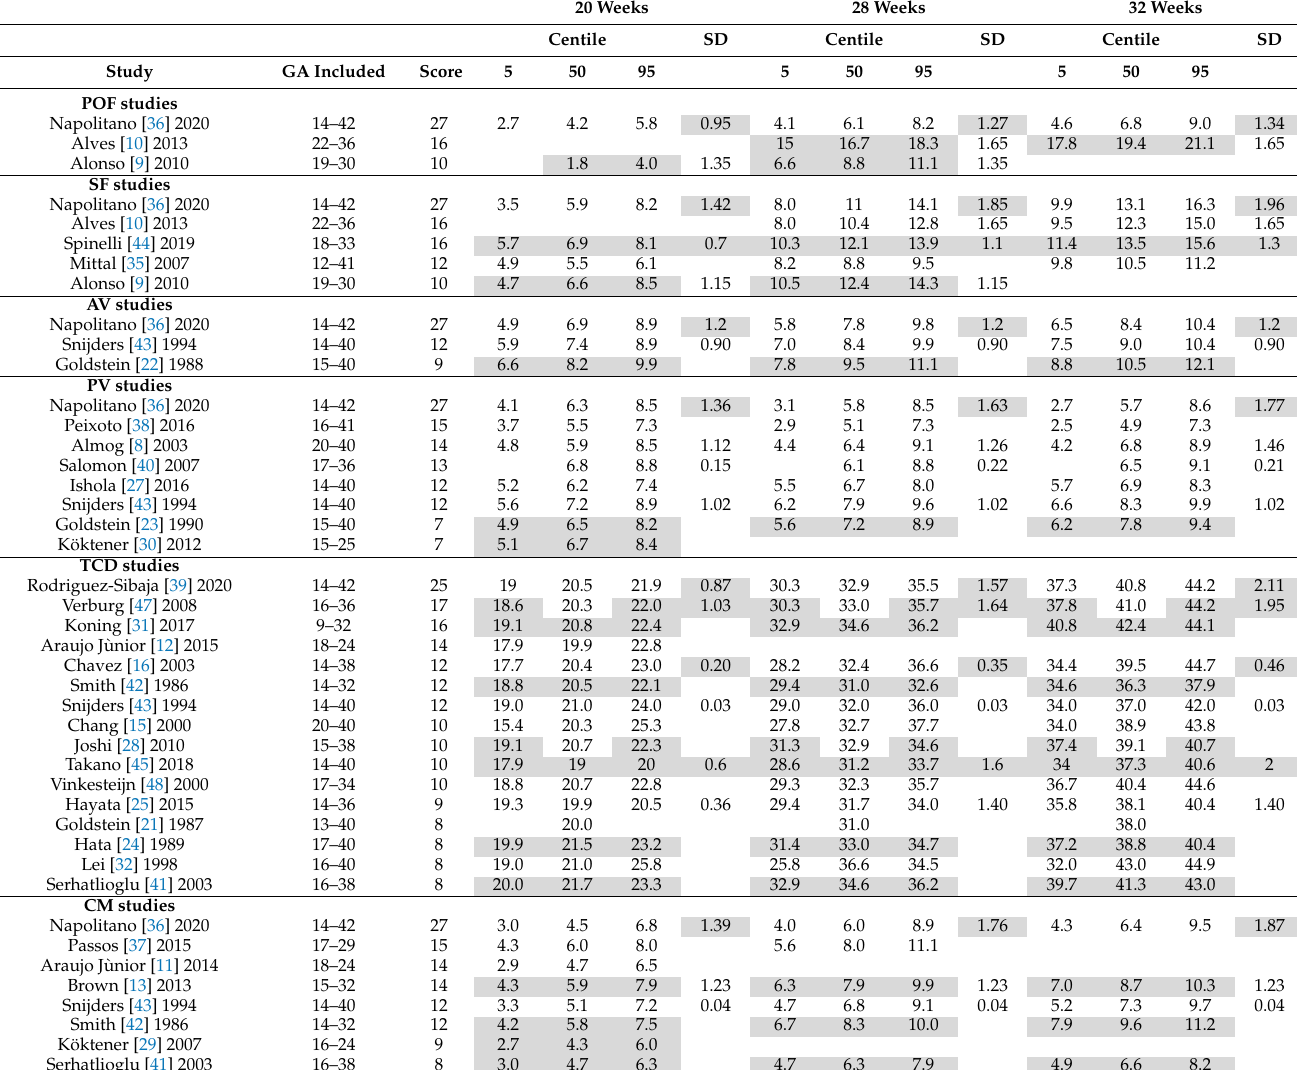
Centiles highlighted in white are reported in the relative study; centiles highlighted in grey are calculated. Studies are reported in descending quality score. SD= standard deviation; POF = parieto-occipital fissure; SF = Sylvian fissure; AV = anterior ventricle; PV = posterior ventricle; TCD = transcerebellar diameter; CM = cisterna magna; GA = gestational